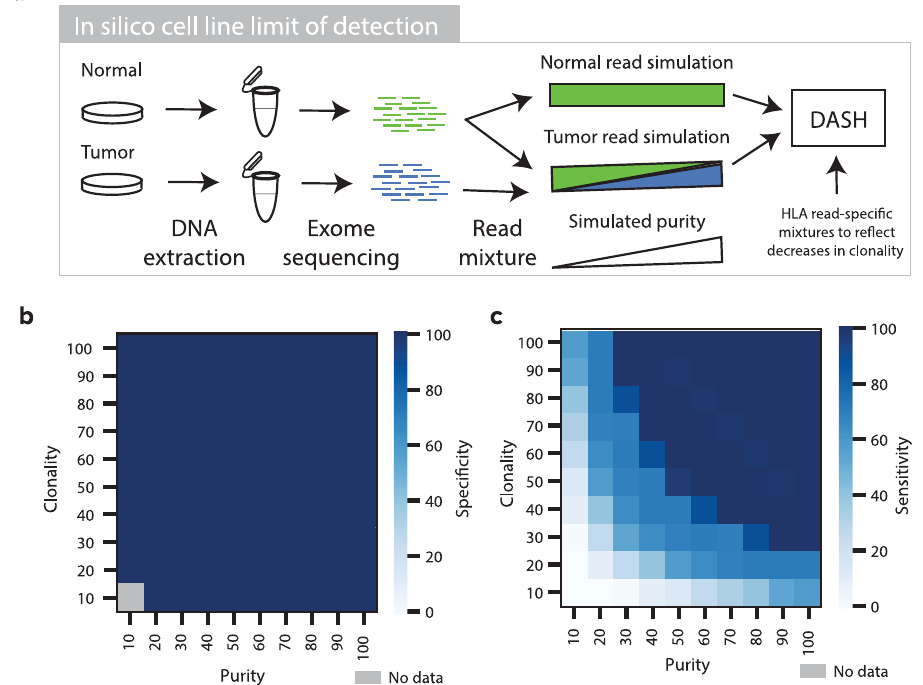
Fig. 2 In silico cell line mixtures to determine DASH limit of detection. a A schematic showing the tumor and normal cell line mixing approach for simulating low-purity sample pairs. b and c Heatmaps showing the b speci fi city and c sensitivity of DASH to capture HLA LOH in simulated samples of differing purity and clonality. Dark blue denotes high sensitivity or speci fi city, light blue denotes low sensitivity or speci fi city and gray denotes no data. Source data are provided with this